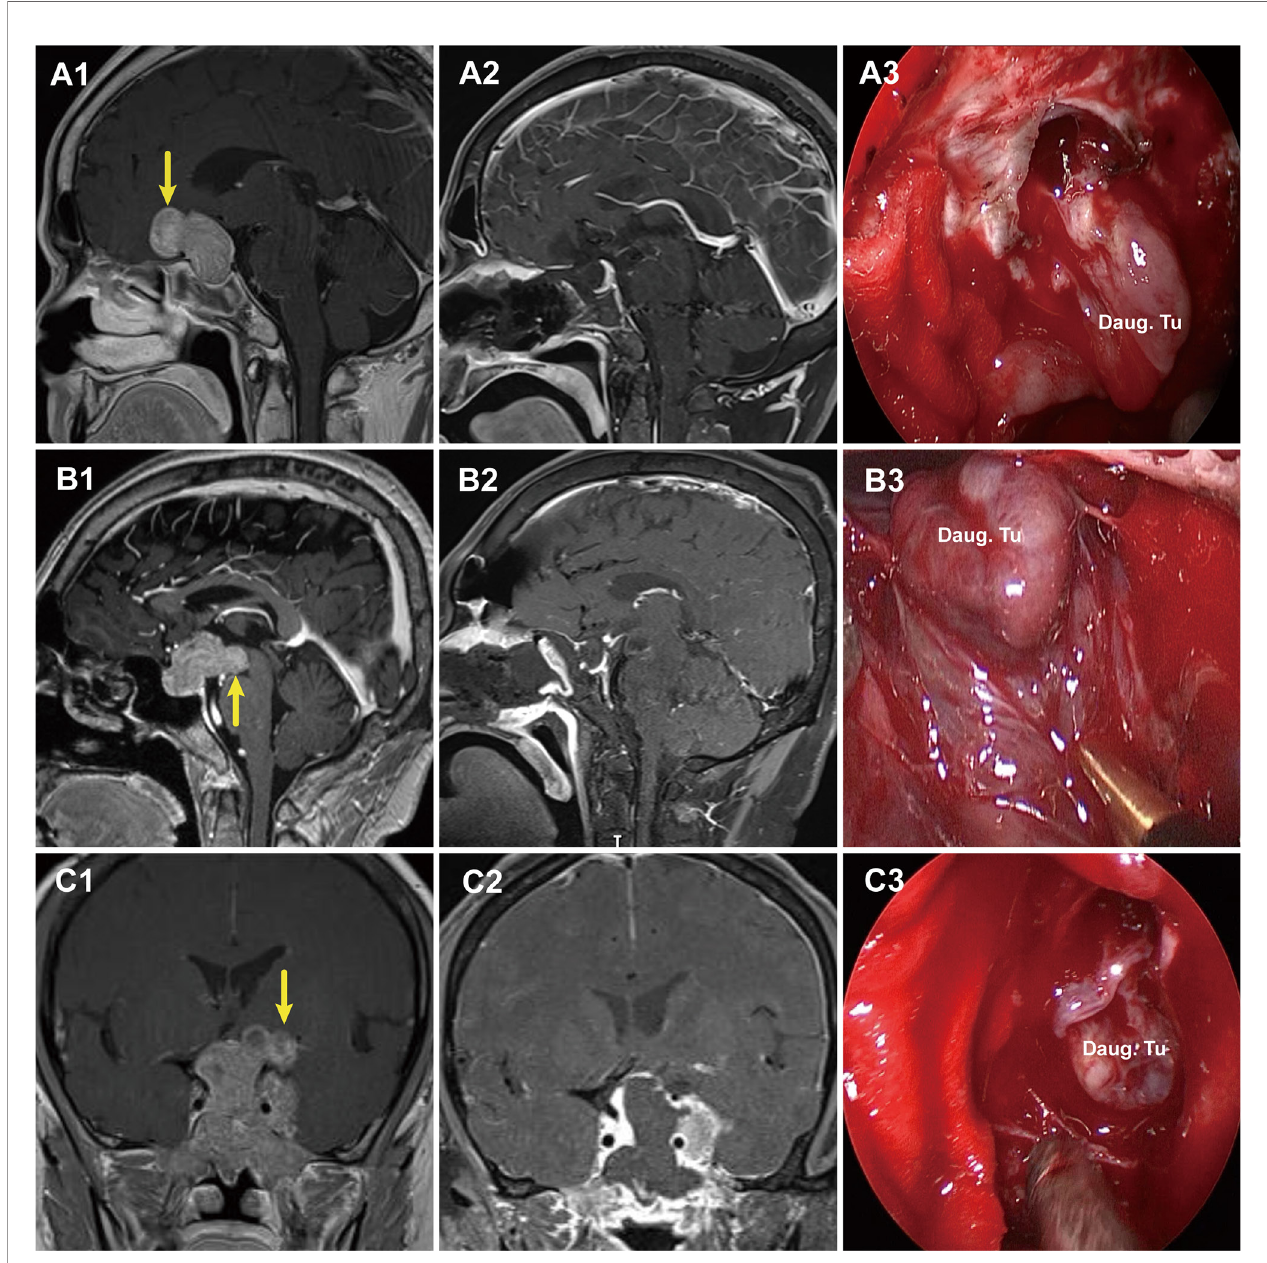
FIGURE 4 | Three cases with grade 1b PAs that underwent endoscopic endonasal surgery. (A1, B1, C1) Preoperative, sagittal post-gadolinium MRIs showing 3 grade 1b tumors with daughter tumor (yellow arrow) extending to the anterior skull base (A1) , the interpeduncular fossa (B1) , and the suprasellar lateral (C1) . (A2, B2, C2) Postoperative MRI demonstrating gross total resection of suprasellar part of tumor was achieved. (A3, B3, C3) Endoscopic views showing the intact wall of daughter tumor. Daug. Tu, daughter tumor; DS, diaphragm